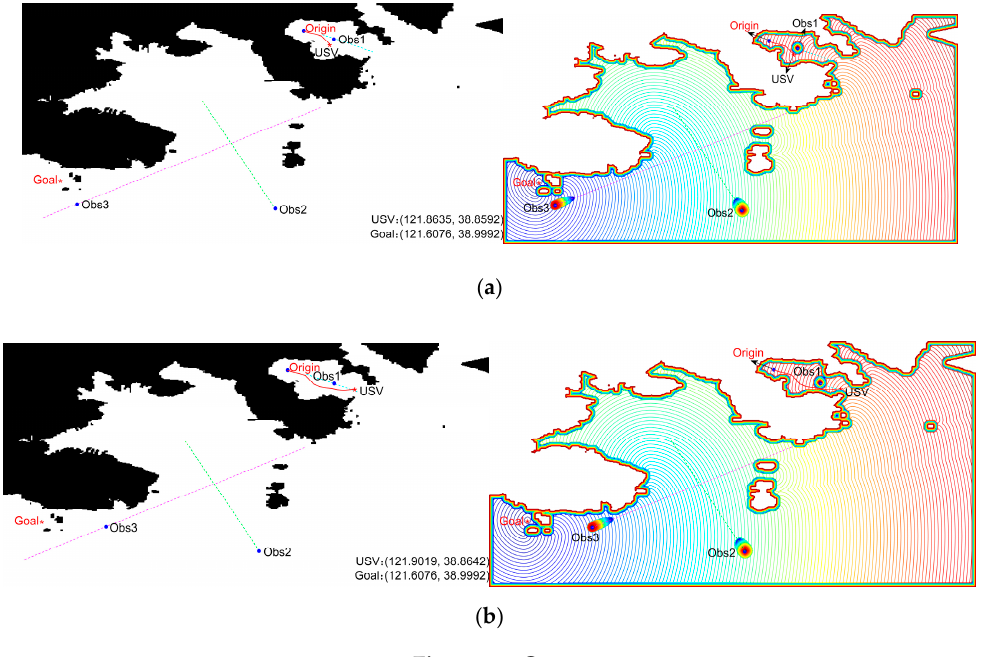
Figure 27. Simulation cycle 1, namely, the initial state: ( a ) task and location information; ( b ) the corresponding potential field.